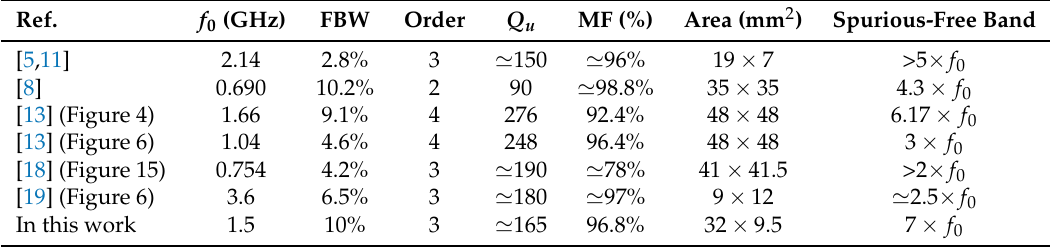
Table 4. Comparison table between references and proposed CSIW